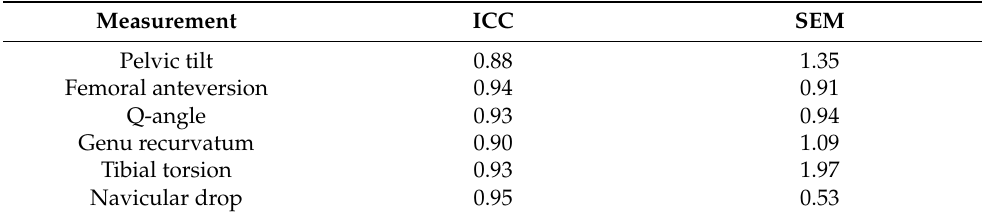
Table 1. Intraclass correlation coefficient (ICC) and standard error of the measurement (SEM) for each lower extremity alignment